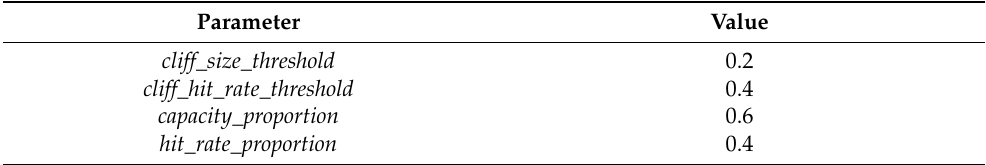
Table 2. The algorithm parameters.